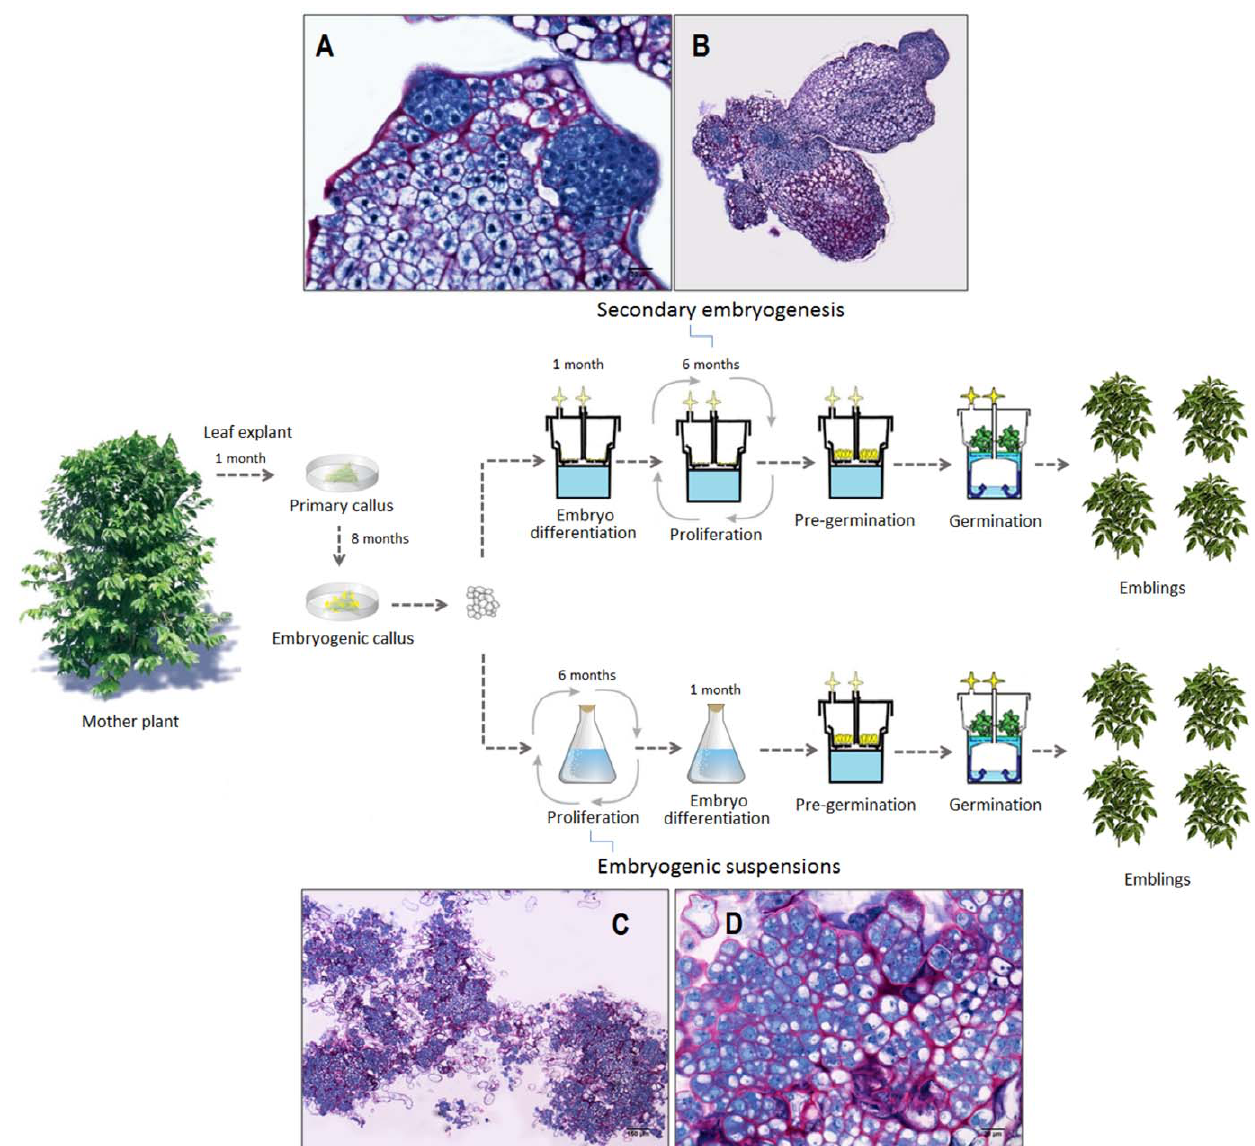
Figure 1. Schematic representation of two somatic embryogenesis processes applied at the industrial level. The first somatic embryogenesis process (upper section of the flow diagram) involved a proliferation step based on secondary embryogenesis in RITA H temporary immersion bioreactors (photos 1A, 1B). The second process (lower section of flow diagram) included a proliferation step based on embryogenic suspensions (photos 1C, 1D). 1A, initial developmental stages of secondary embryos at the root pole of primary somatic embryos; 1B, clusters of primary and secondary embryos; 1C, clusters of embryogenic cells in suspension; 1D, embryogenic cells in suspension.